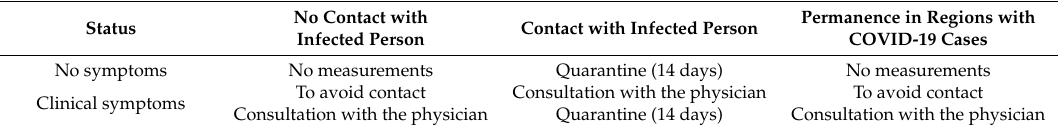
Table 1. Risk assessment for professionals (Occupational Health Service, Hospital University